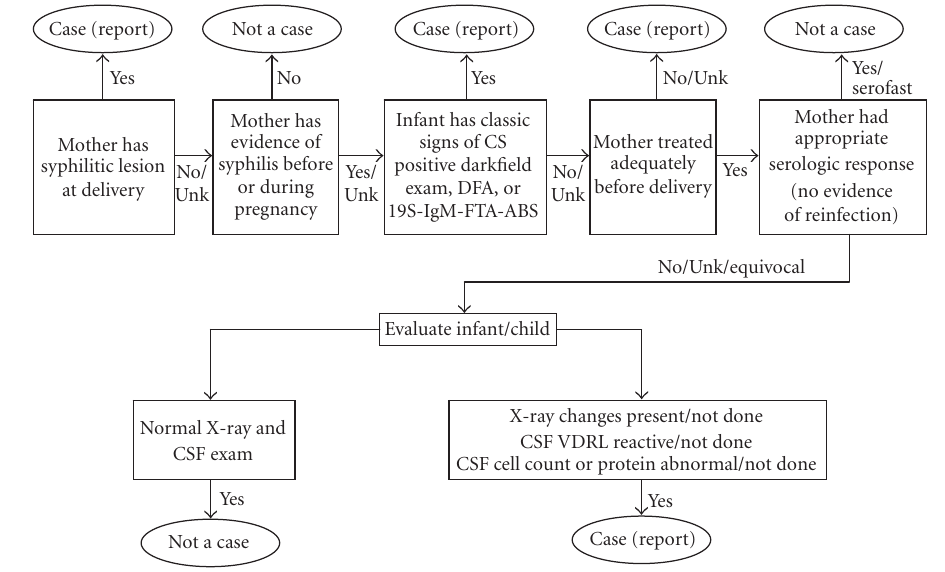
Figure 1: CDC congenital syphilis case investigation algorithm.